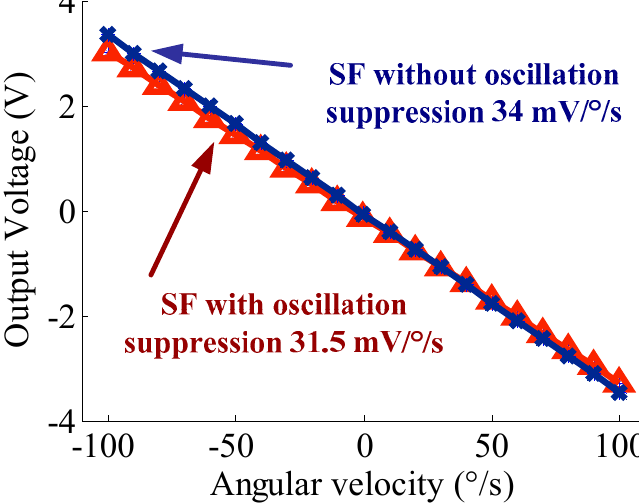
Figure 13. Scale factor comparison of oscillation suppression.